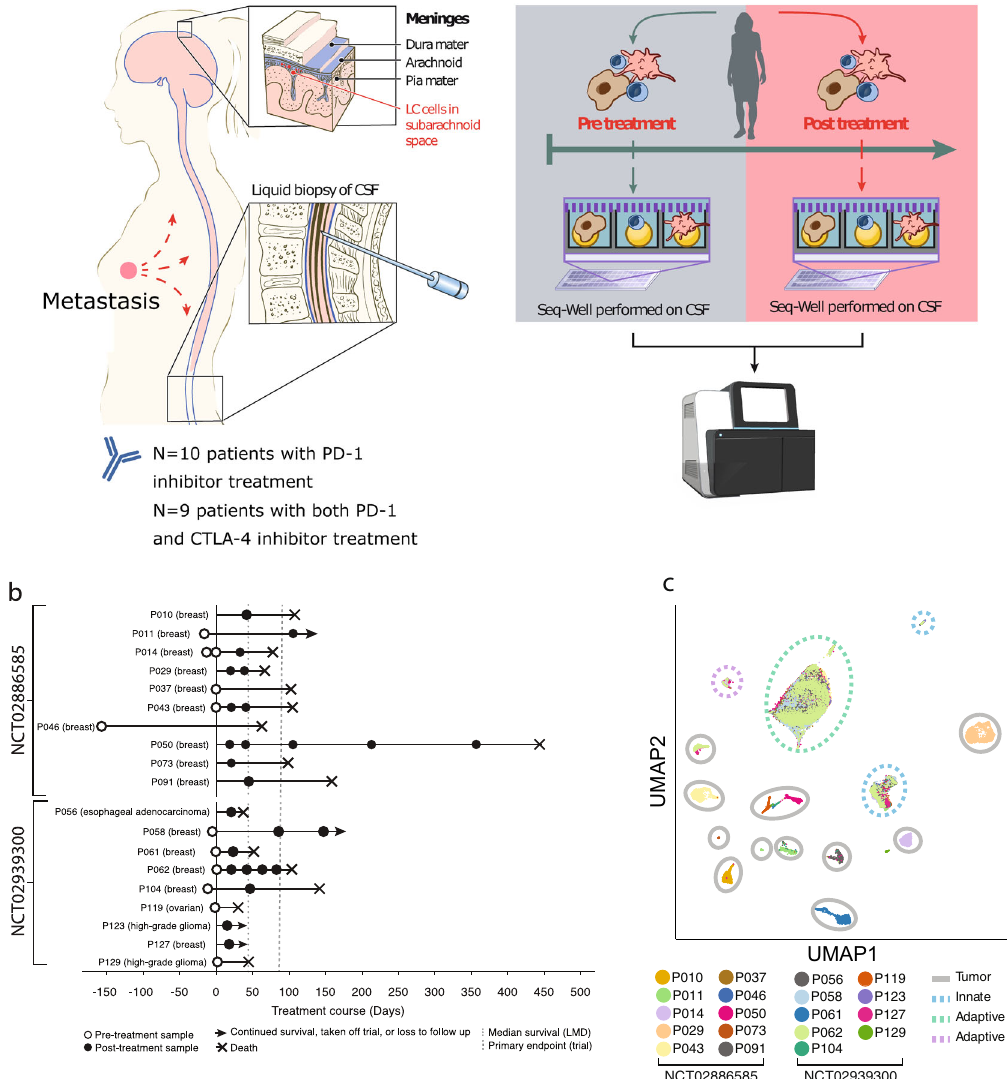
Fig. 1 Development of a pipeline for scRNA/cfDNA from longitudinally sampled CSF samples before and after ICI therapy. a Schematic representation of the longitudinal sampling performed on patients in this study. b Longitudinal sampling overview from patients in each study, including trial primary endpoint (dashed line), and date of patient mortality, when known. c UMAP of single-cell transcriptomes from all captured CSF cells in both trials, colored by patient, with cell type of origin